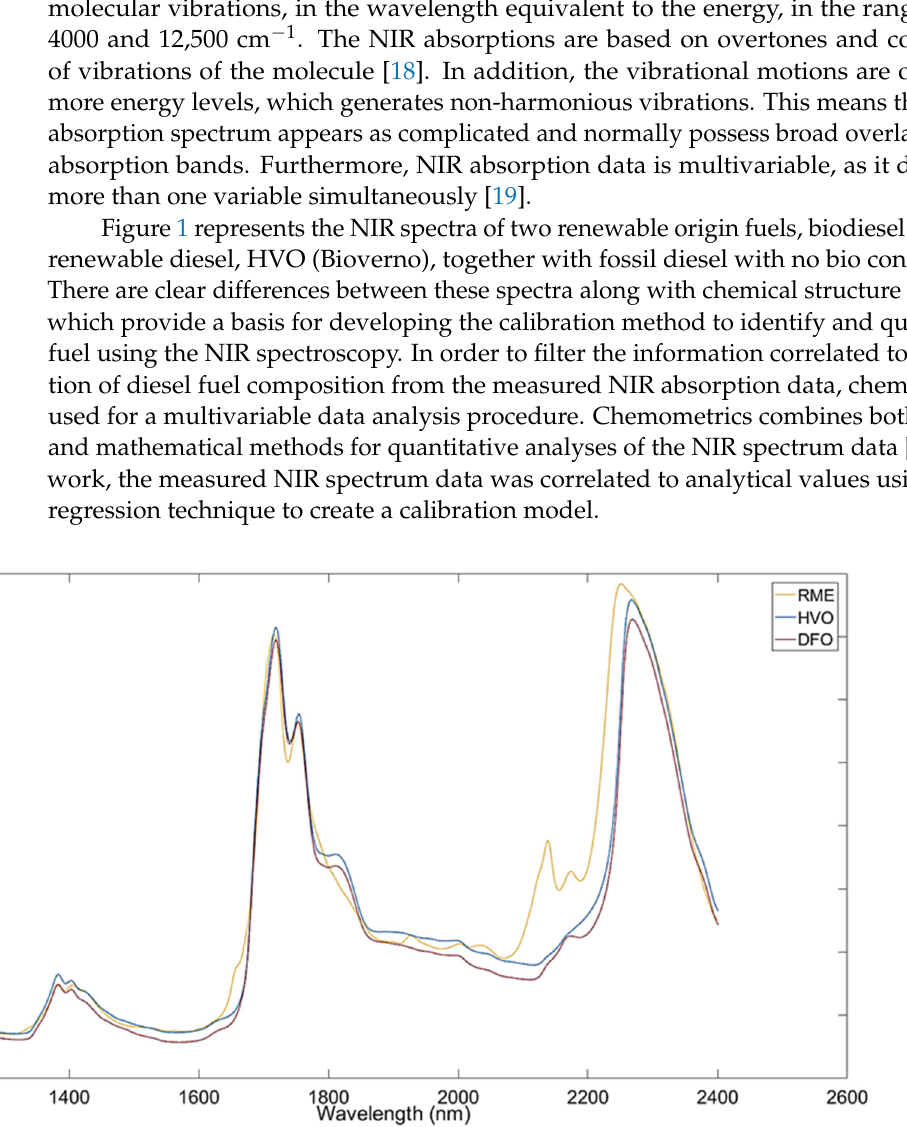
Figure 1. NIR spectra of biodiesel (RME), renewable diesel (HVO, Bioverno) and fossil diesel fuel (DFO).